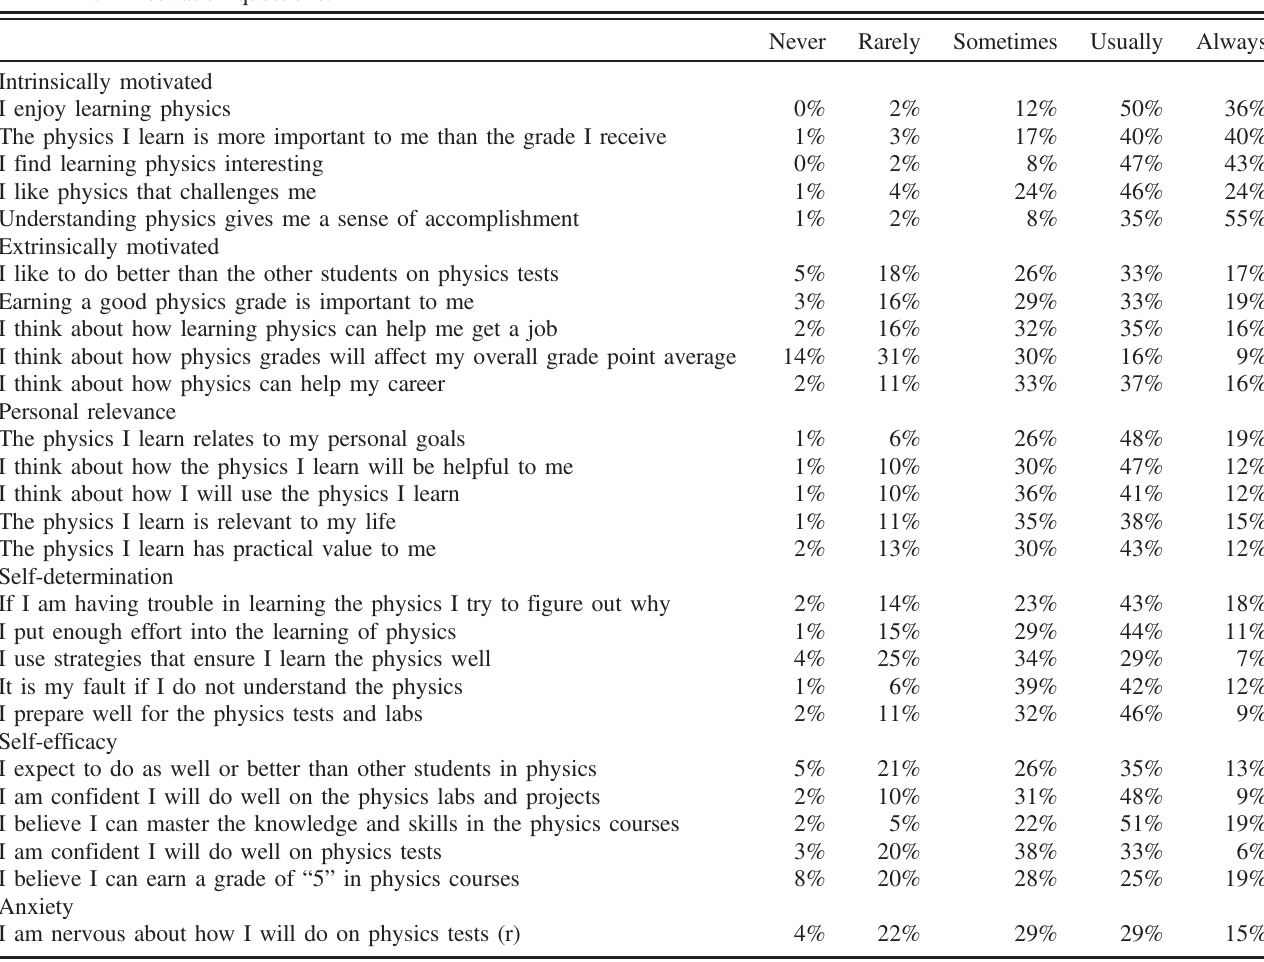
TABLE V. Motivation questions.